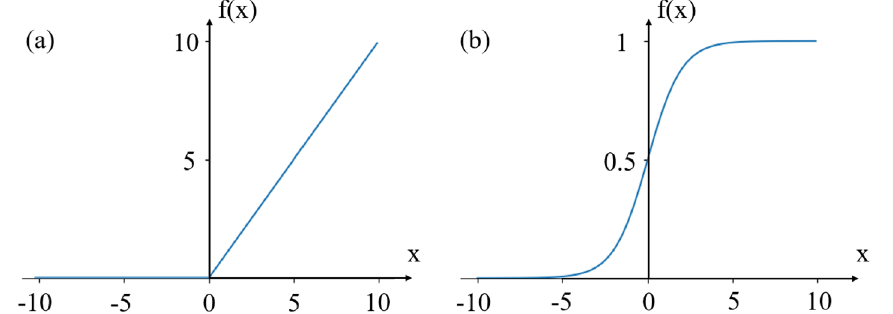
Figure 2. ReLU activation function ( a ) and Sigmoid activation function ( b